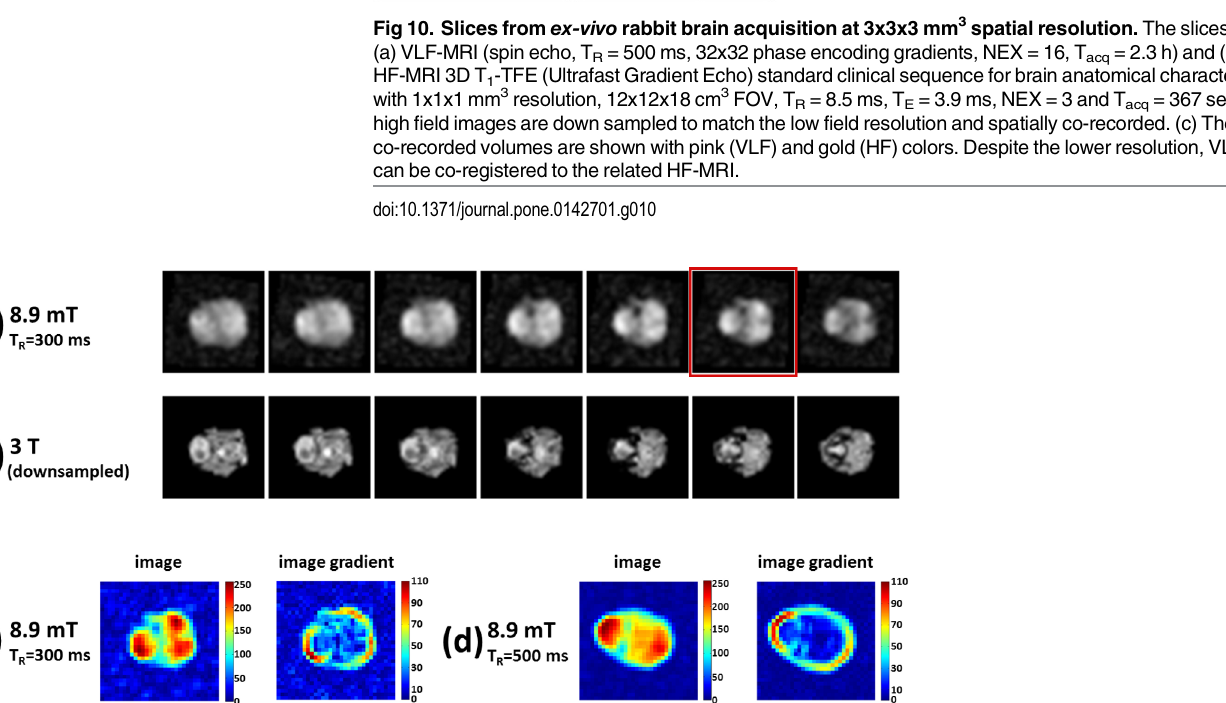
Fig 11. Slices from a second ex-vivo rabbit brain acquisition at 3x3x3 mm 3 spatial resolution. The slices compare (a) VLF-MRI (spin echo, T R = 300 ms, 32x32 phase encoding gradients, NEX = 9, T acq = 46 min) and (b) HF-MRI 3D T 1 -TFE as in Fig 10. Two homologous VLF slices of the two rabbit heads, the second slice from the top in Fig 10A (T R = 500 ms) and the sixth slice from the left in Fig 11A (T R = 300 ms, with a red frame), are selected. The selected slices and the related gradient images are shown in (c) and (d). The image with shorter T R highlights a larger number of edges inside the rabbit brain than the one with longer T R i.e. the increased tissue contrast helps in delineating structures inside the rabbit